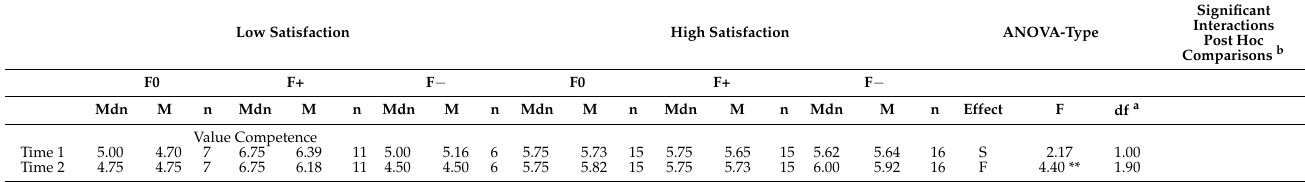
Table 1. Descriptives and nonparametric repeated measures ANOVA-type models of psychological variables for each type of feedback, satisfaction with the coach, time of measure, and their interactions.